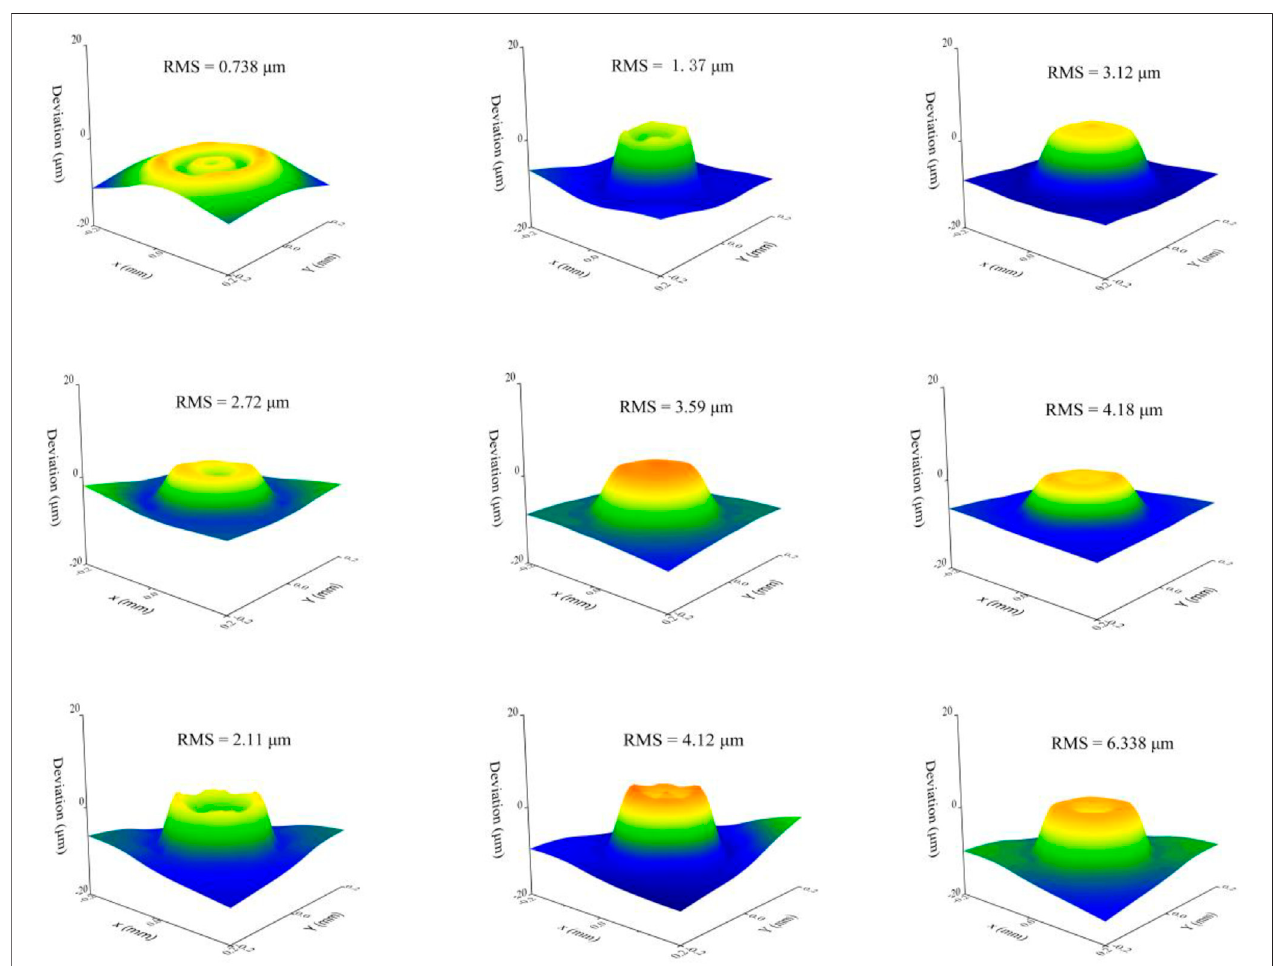
FIGURE 14 | Experimental data and simulation deviation values for nine combinations and root-mean-square values.